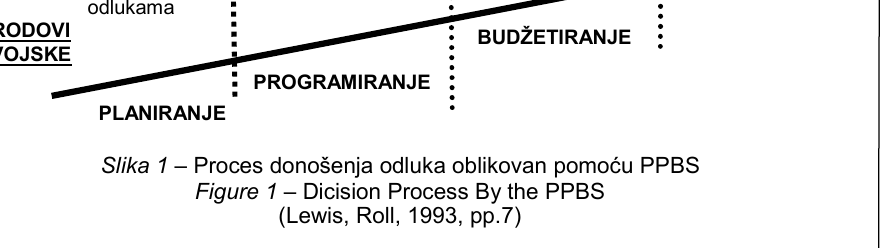
Figure 1 – Dicision Process By the PPBS (Lewis, Roll, 1993,